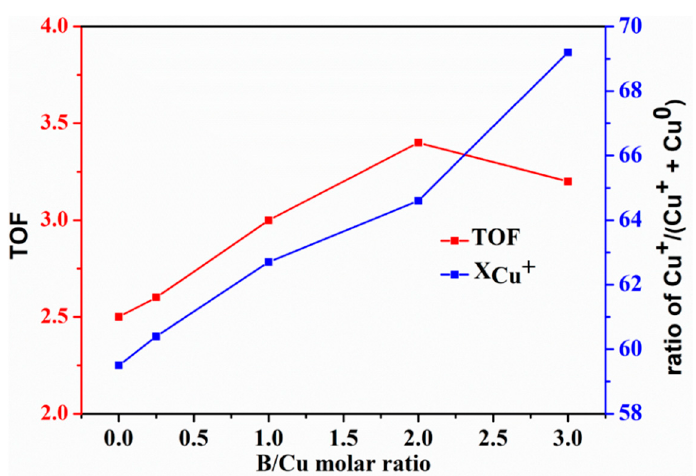
Figure 8. The correlation relationship between TOF and Cu + /(Cu 0 + Cu + ) intensity ratio.